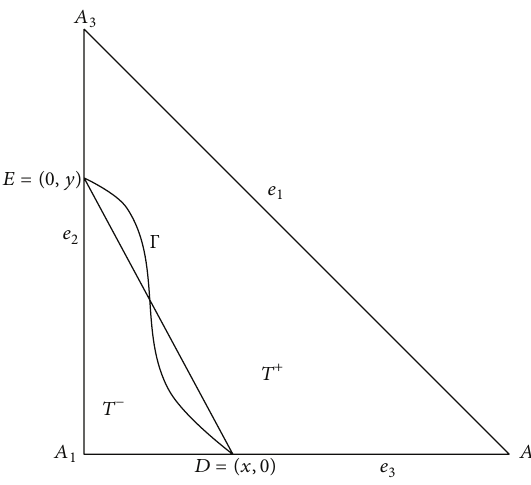
Figure 2: A typical interface